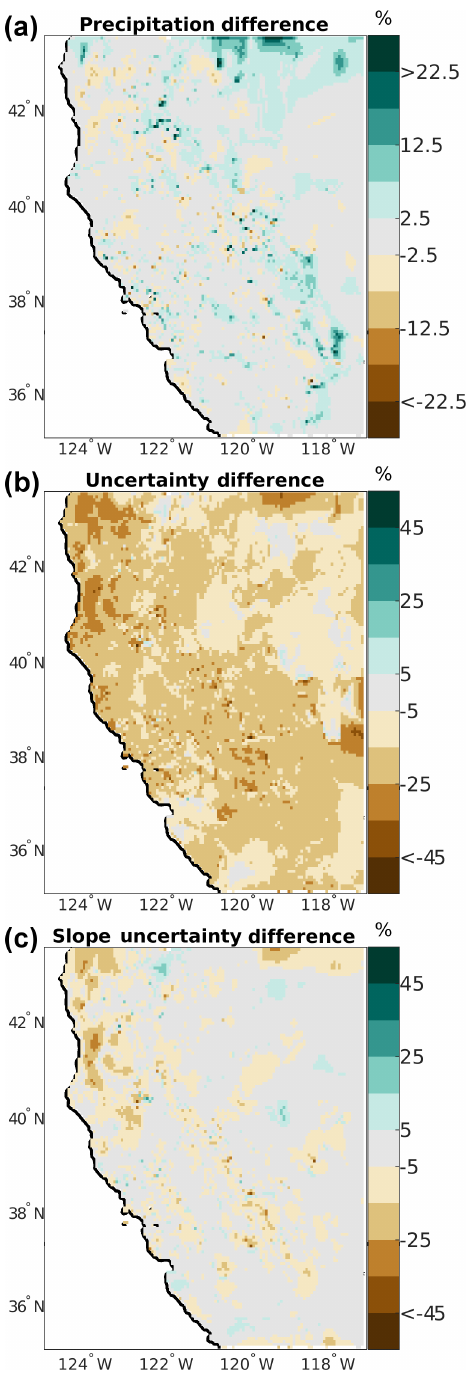
Figure 11. Spatial distribution of differences for model parameter sensitivity experiment 3, modified maximum number of stations pa- rameter (nMaxNear). (a) Precipitation differences (%), (b) total un- certainty differences (%), and (c) uncertainty changes due to the slope term in the